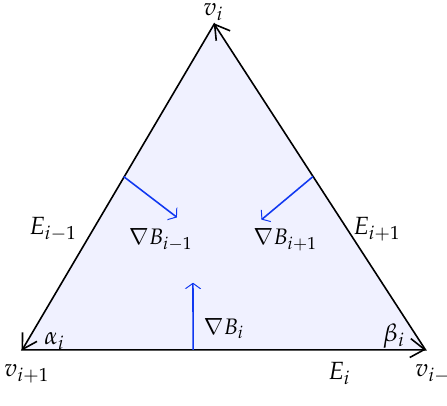
Figure 15. The gradients of hat functions of a triangle.